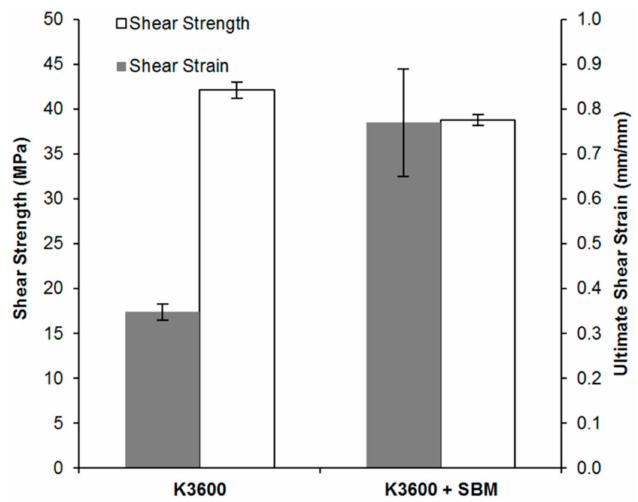
Figure 9. Shear strength and ultimate shear strain results for neat and SBM-toughened K3600. Error bars show standard deviation in each data set.